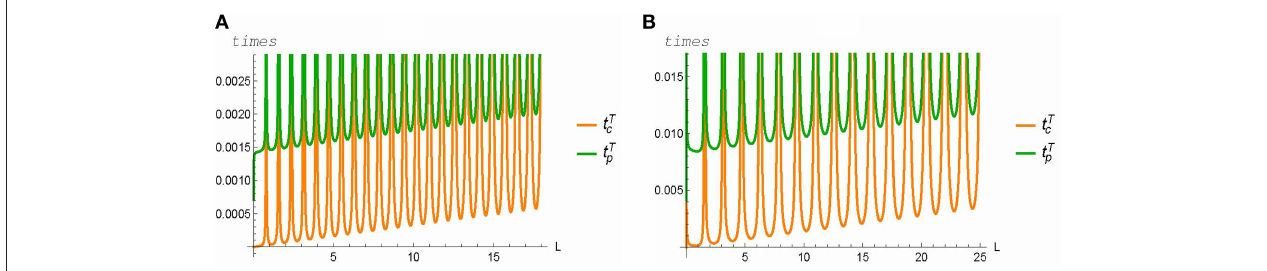
FIGURE 1 | Tunneling times for even arrangements of two point interactions (in atomic Rydberg units). (A) Double- δ , with γ δ ′ with γ 120 and k 1.0 = =